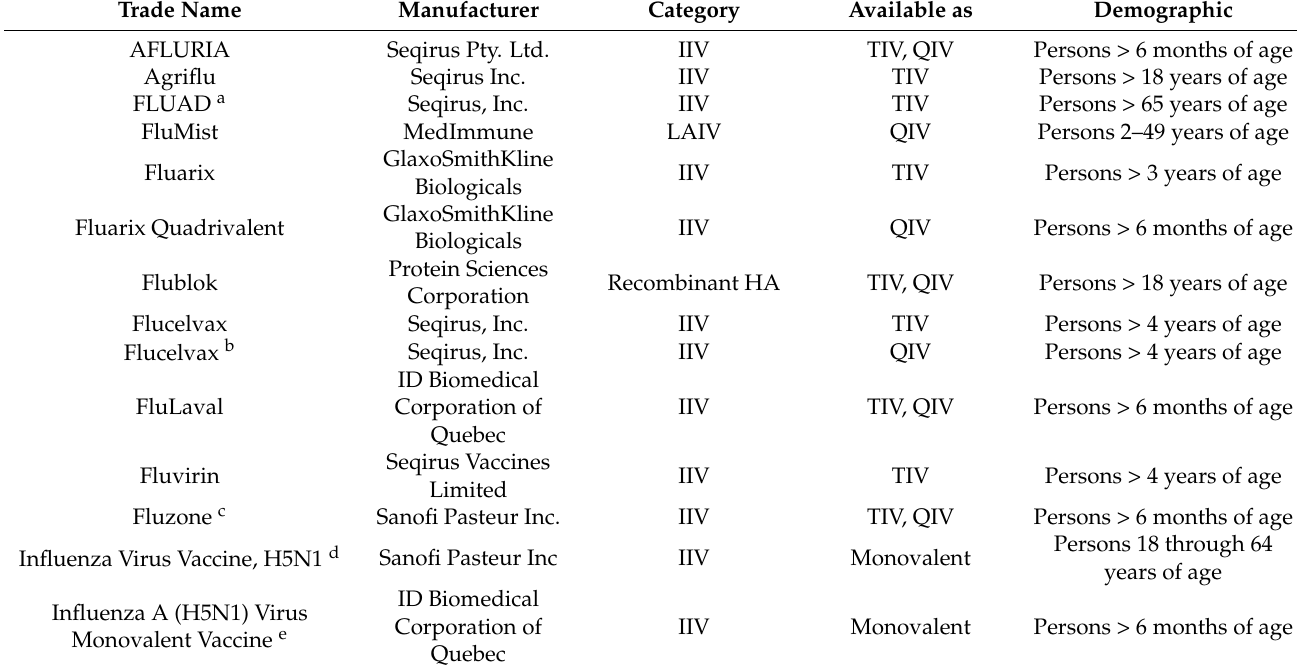
Table 1. Influenza virus vaccines currently on the US market